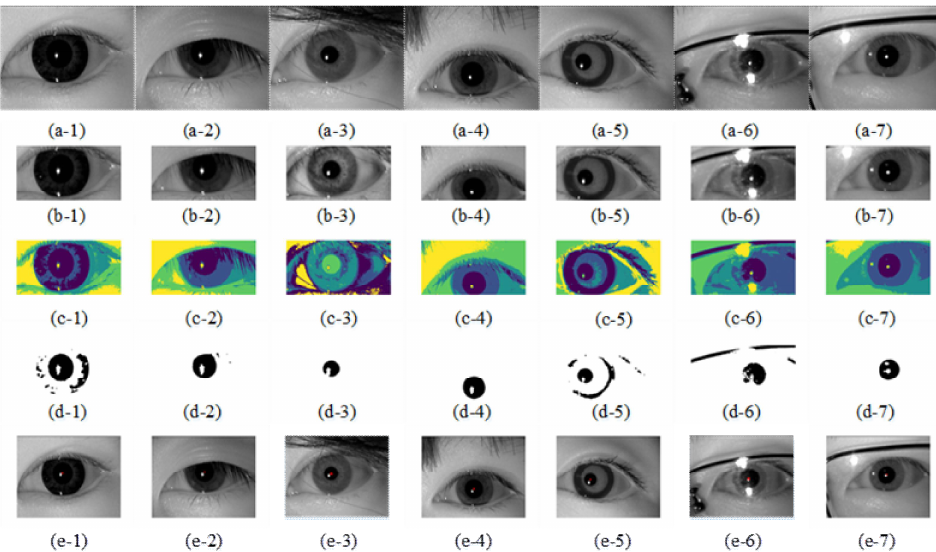
Figure 11. Dataset II image pupil segmentation detection process. ( a-1 )–( a-7 ) are the original images of different low-quality eye images; ( b-1 )–( b-7 ) are the eye images after fusing image gray intensity information and spatial location information filtering; ( c-1 )–( c-7 ) are the eye images after using fuzzy clustering segmentation; ( d-1 )–( d-7 ) are the eye images after extracting the pupil binarization process; ( e-1 )–( e-7 ) are the detected pupil center locations, and the red cross “ × ” is the pupil center. Table 5. Pupil segmentation detection results.